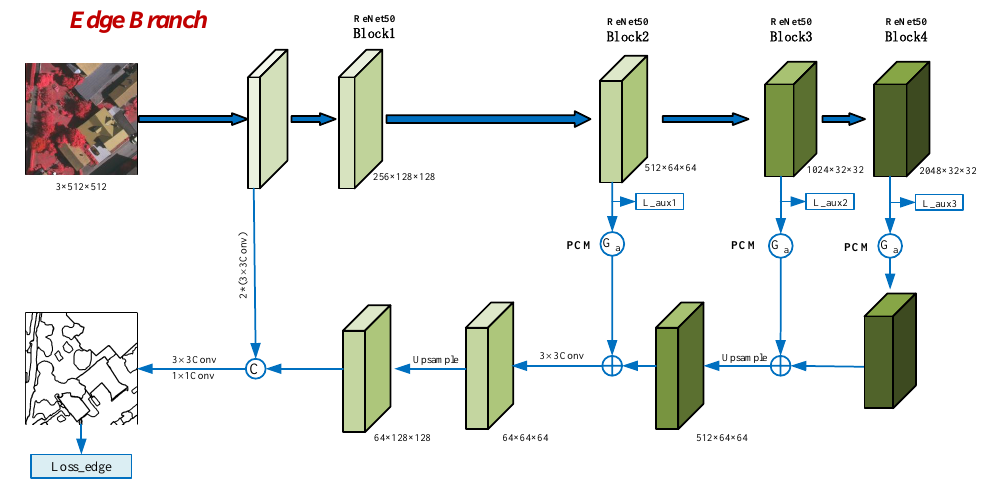
Figure 5. The framework of the edge